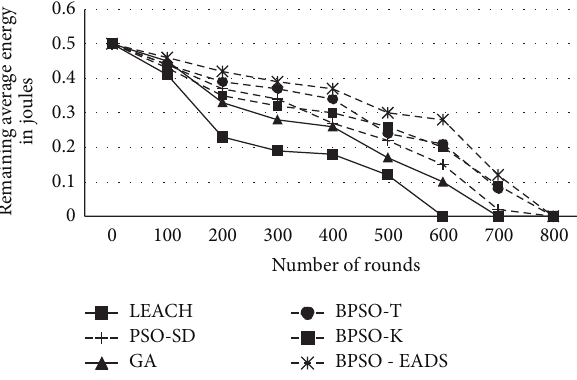
Figure 7: Average energy in the network after each